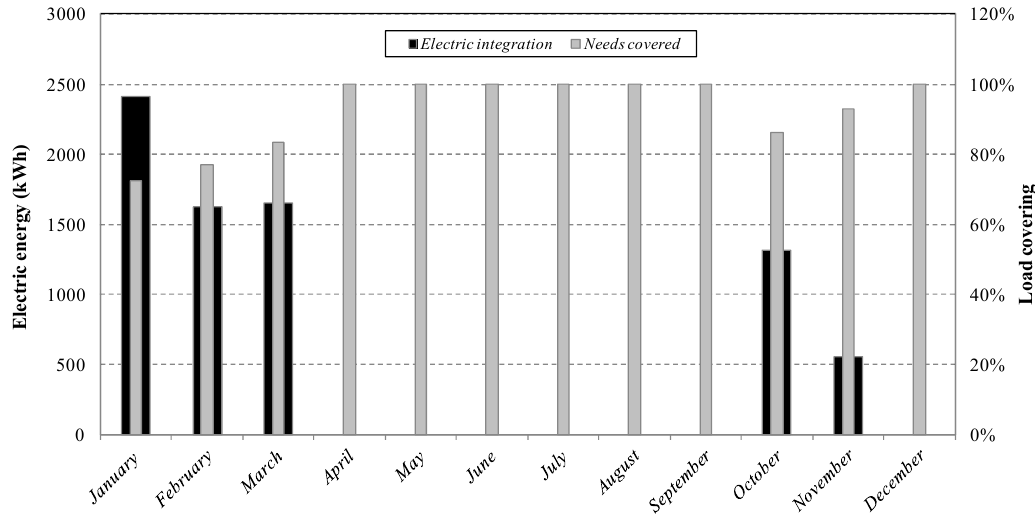
Figure 12. Annual electrical covering (%) by means of the CPV / T-ORC system and electrical energy integration required (kWh) for the industrial user.